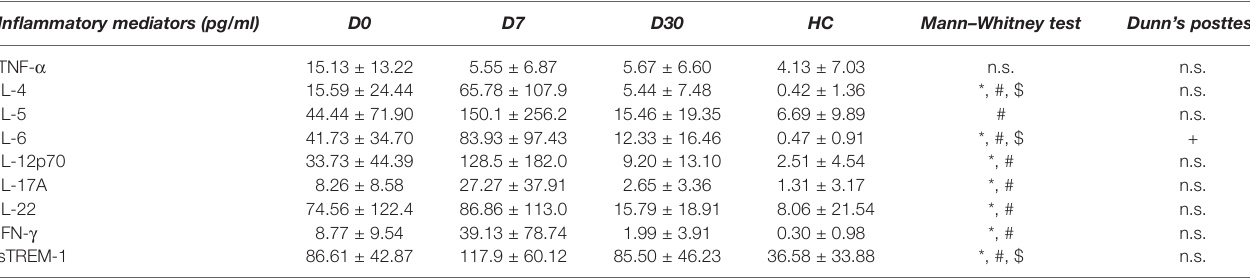
TABLE 2 | In fl ammatory mediator pro fi le of patients with VL at different times of leishmanicidal treatment. In fl ammatory mediators